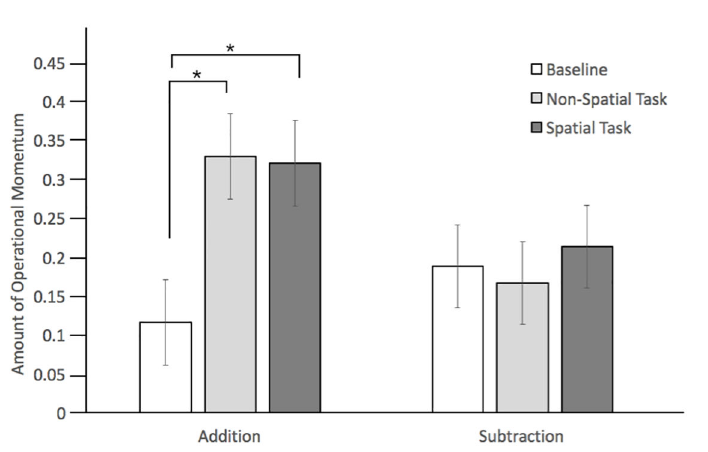
Figure 2. The amount of operational momentum as a function of condition and arithmetic operation. Error bars reflect +/- 1 SEM. Between-subjects’ effects of condition only are noted; an asterisk indicates a significant difference of p < .05.